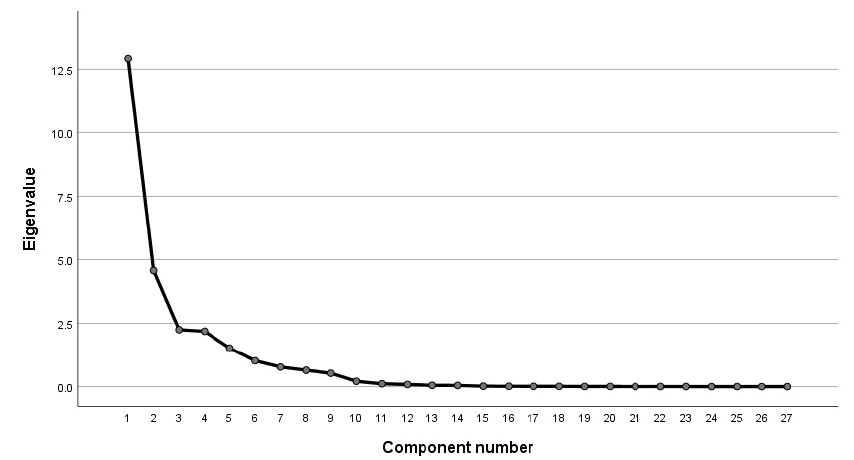
Figure 6. Lithograph of the simulated driving test data. Table 7. Total explained variance of the simulated driving test data.